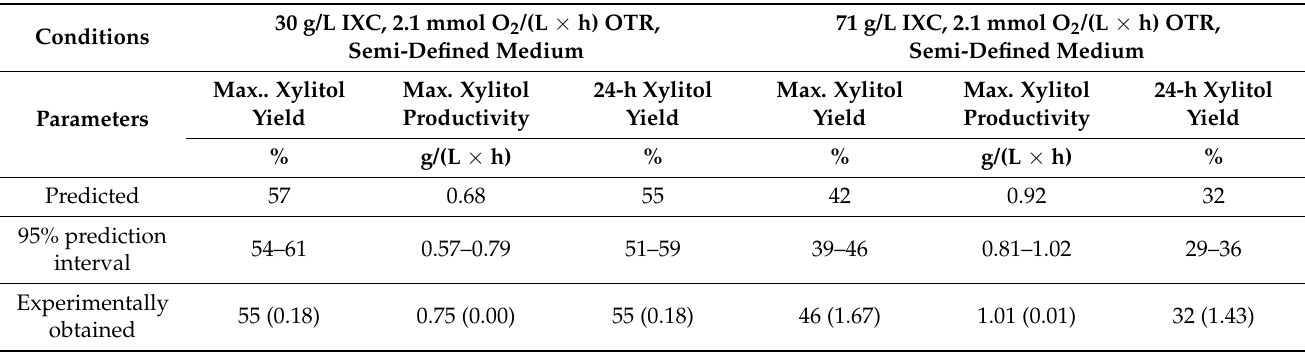
Figure 2. Profiles of fermentations performed at 2.1 mmol O 2 /(L × h) OTR on semi-defined medium containing an initial xylose concentration of 30 g/L ( A ) and 71 g/L ( B ) using Candida boidinii Y.01308. Standard deviations are calculated from duplicates. Table 3. Maximum xylitol yield, maximum xylitol volumetric productivity, and xylitol yield after 24 h of model predictions and experiments. (OTR: oxygen transfer rate, IXC: initial xylose